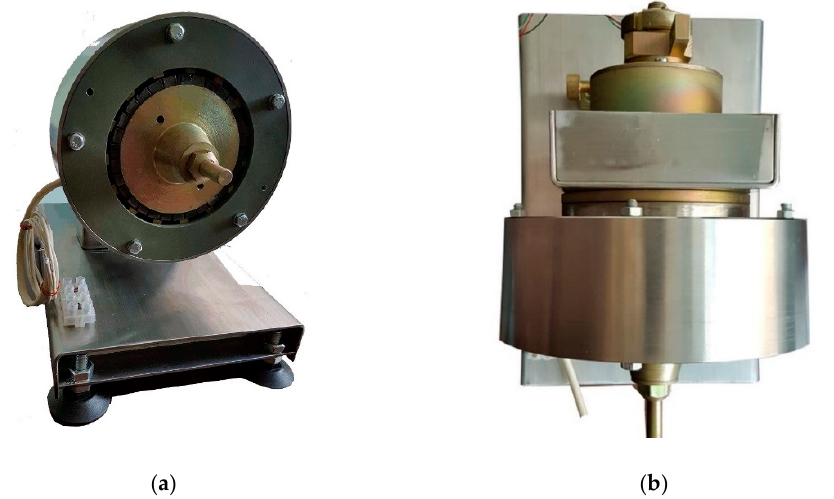
Figure 3. The frontal and top views of the TFM prototype with an inner rotor: ( a ) the photograph of Figure 3. The side and top views of the TFM prototype with an inner rotor and the measurement system: ( a ) drawings the frontal view; ( b ) the photograph of the top view. with basic dimensions and ( b ) the photographs of the physical model.